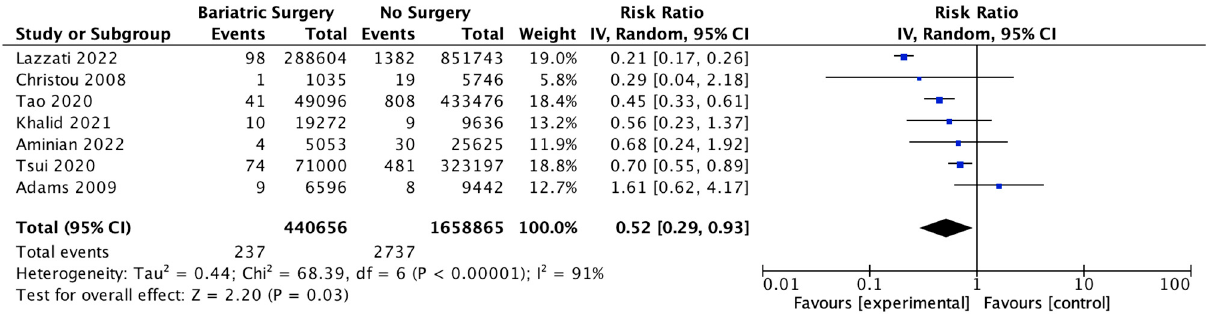
Figure 13. Pancreatic cancer incidence [38–40,42,43,49,50].